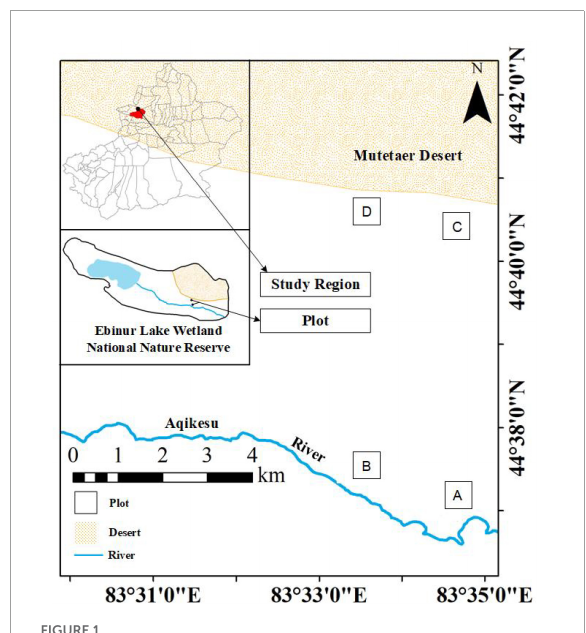
FIGURE1 Study area and plot layout. The distribution area of H. ammodendron . (A) Humid and low salinity, and (B) arid and low salt; the distribution area of H. persicum , (C) humid and low salinity, and (D) arid and